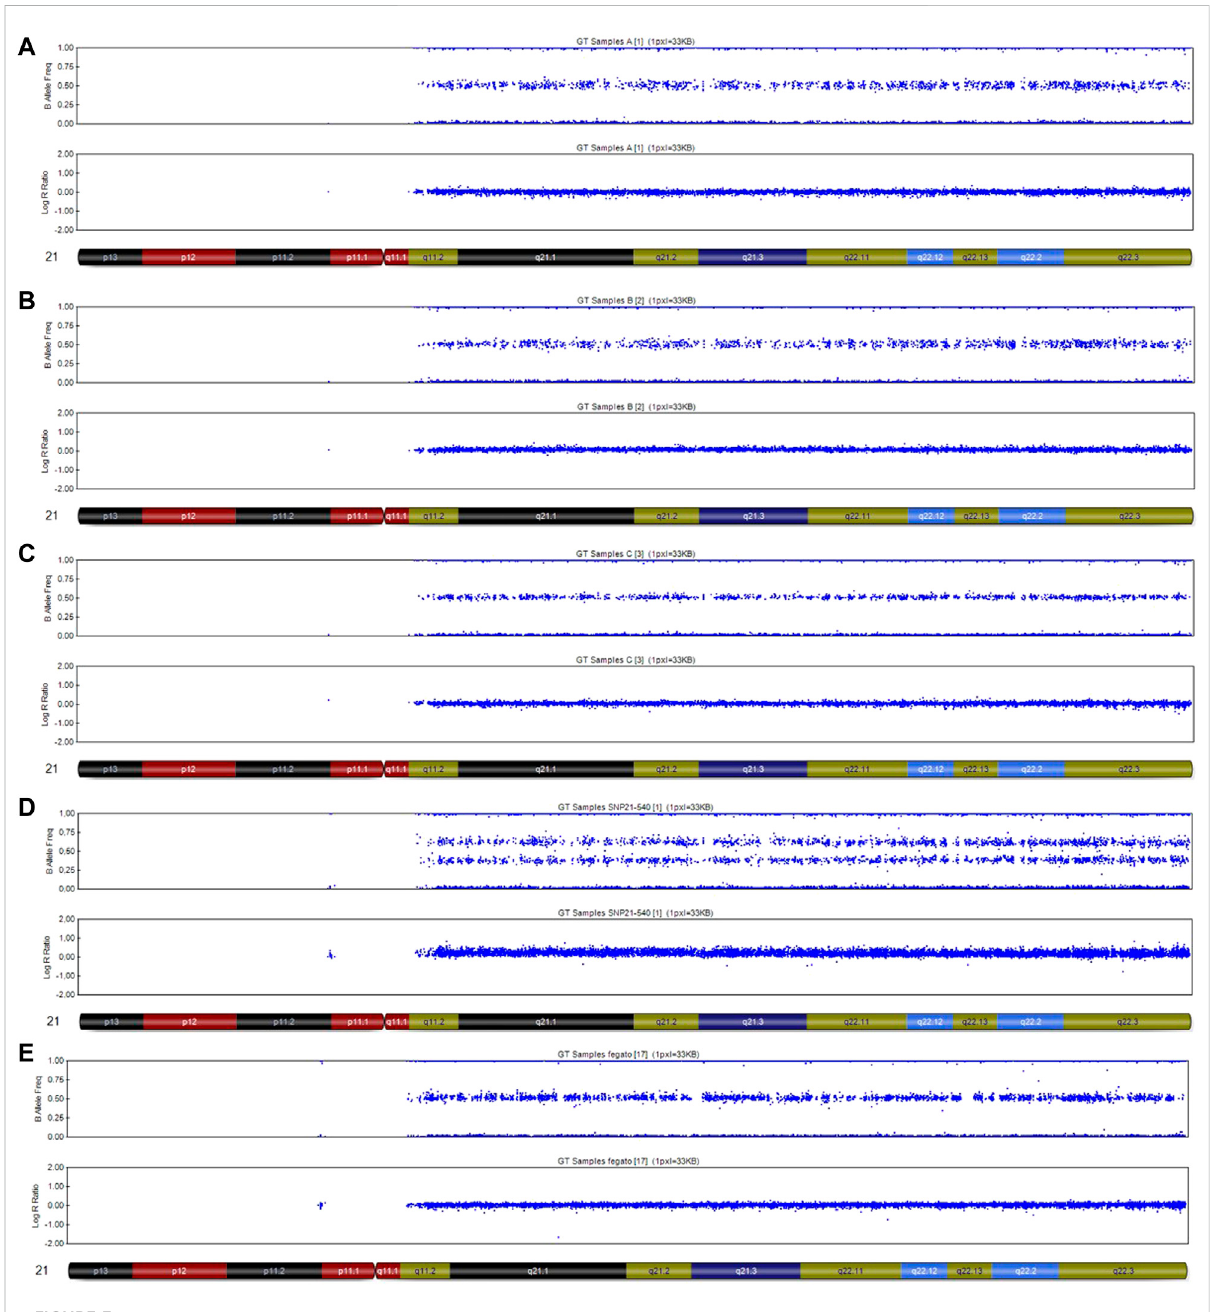
FIGURE 3 SNP-array analysis on placenta and fetal tissues of Case 1. (A) placenta sample 1 DNA, very low level of mosaicisms T21; (B) placenta sample 2 DNA, very low level of mosaicims T21; (C) placenta sample 3 DNA, disomy chromosome 21; (D) fetal skin DNA, complete T21; (E) fetal liver DNA, disomy chromosome